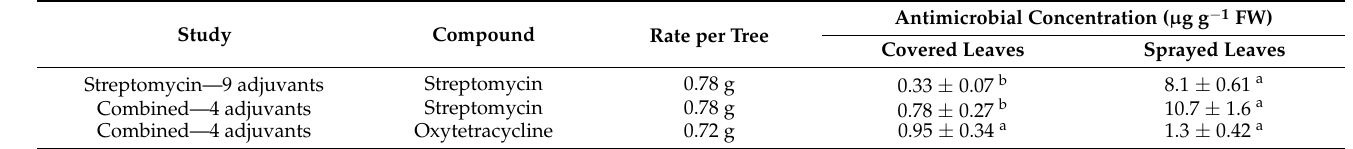
Table 1. Concentrations of streptomycin and oxytetracycline in covered or directly sprayed leaves of ‘Hamlin’ sweet orange ( C. × sinensis ) after foliar application in two different adjuvant studies.